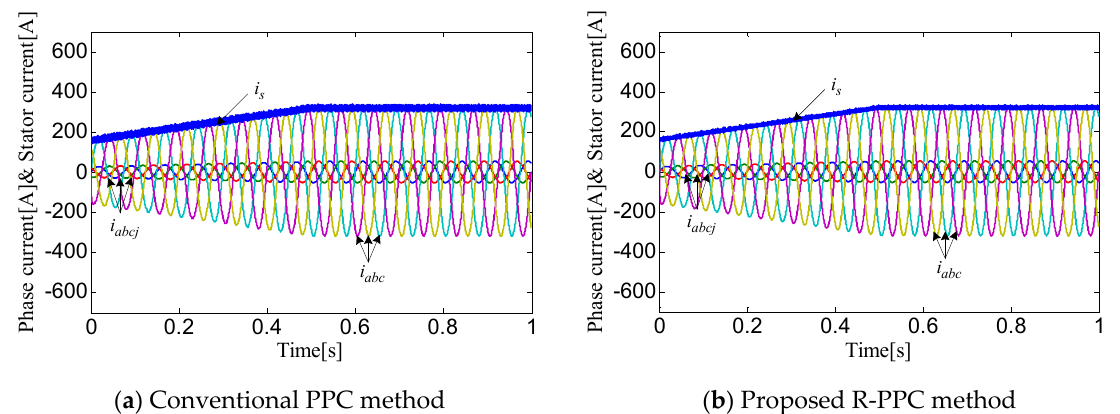
Figure 13. Simulation results of the phase current under the discharge state. ( a ) Conventional PPC method; ( b ) Proposed R-PPC method. FFT window: 3 of 13 cycles of selected signal